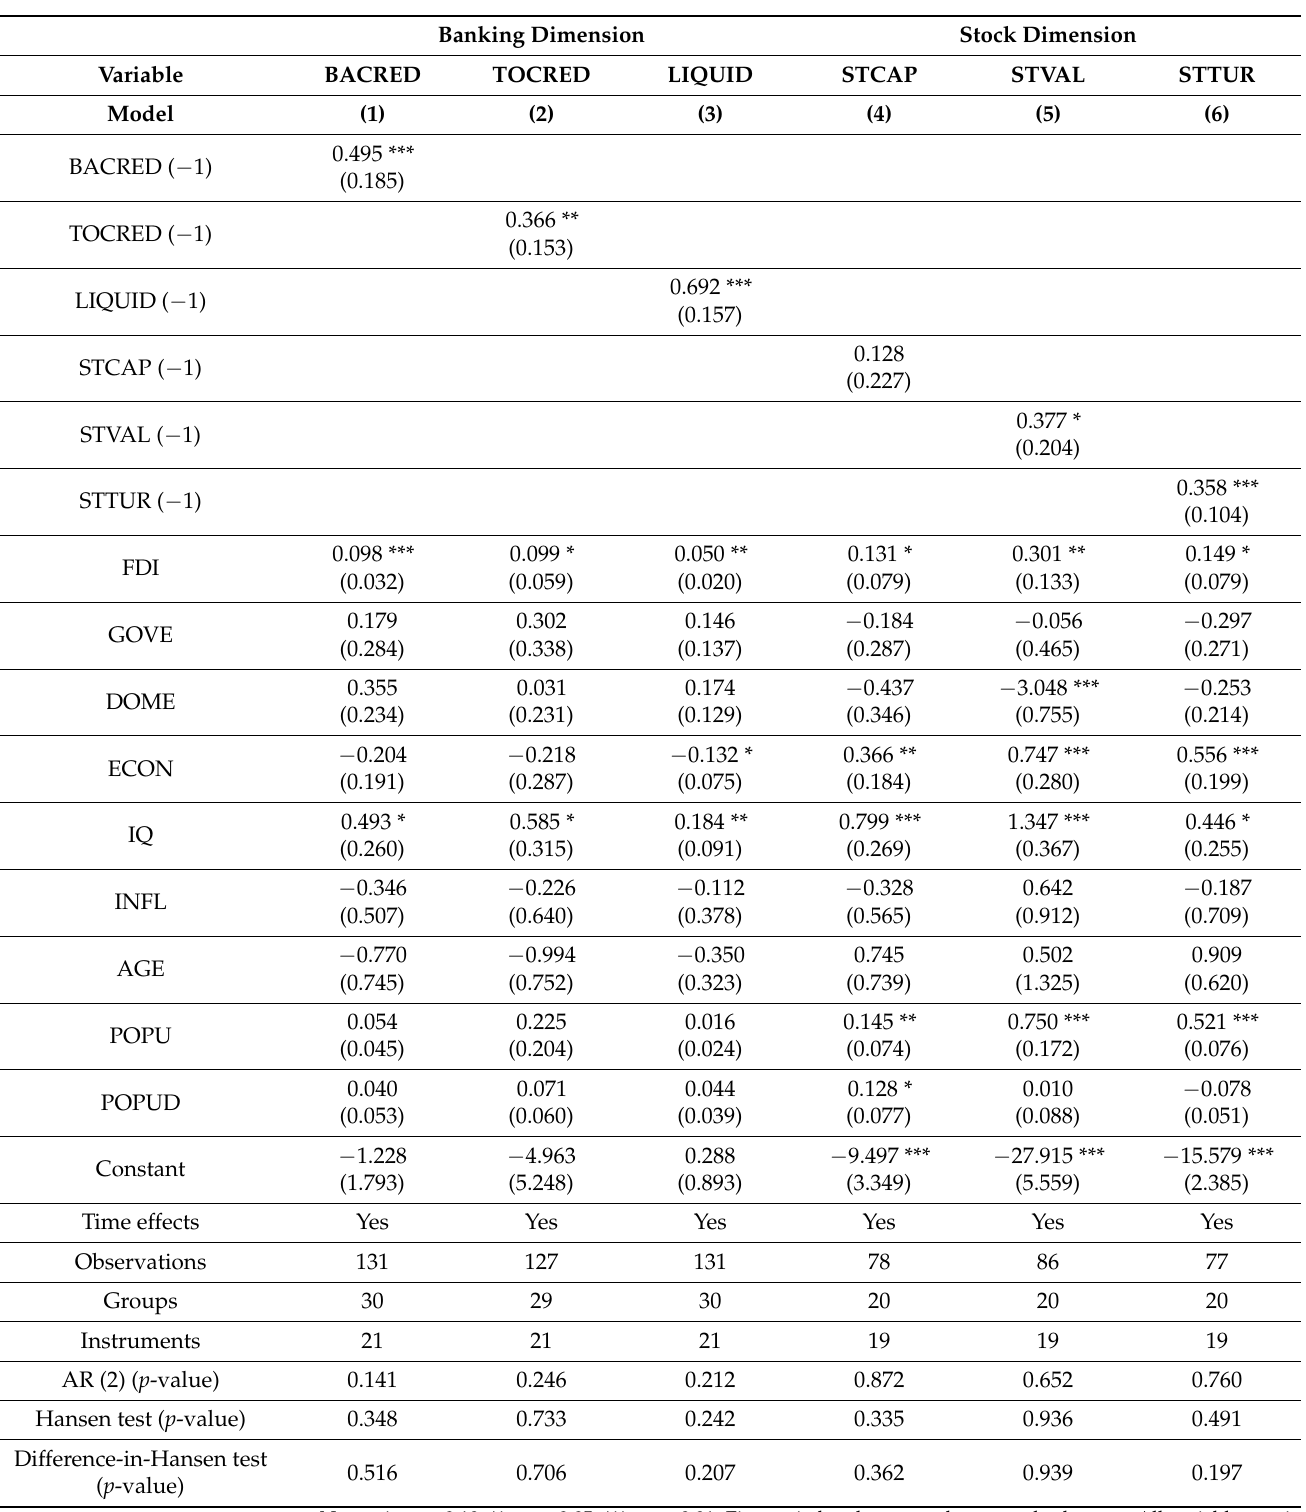
Table 6. The regression results for the impact of FDI on financial